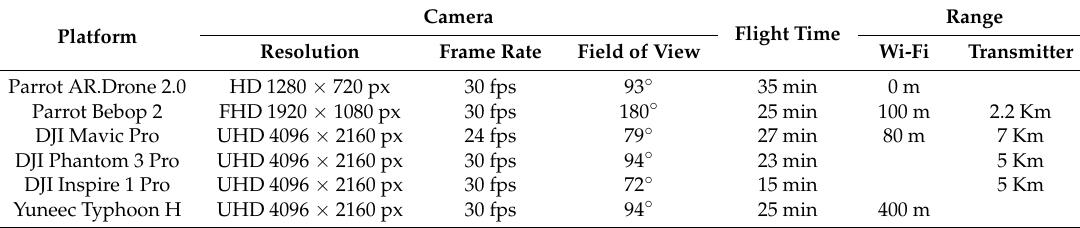
Table 1. Examples of commercial drones with on-board cameras.